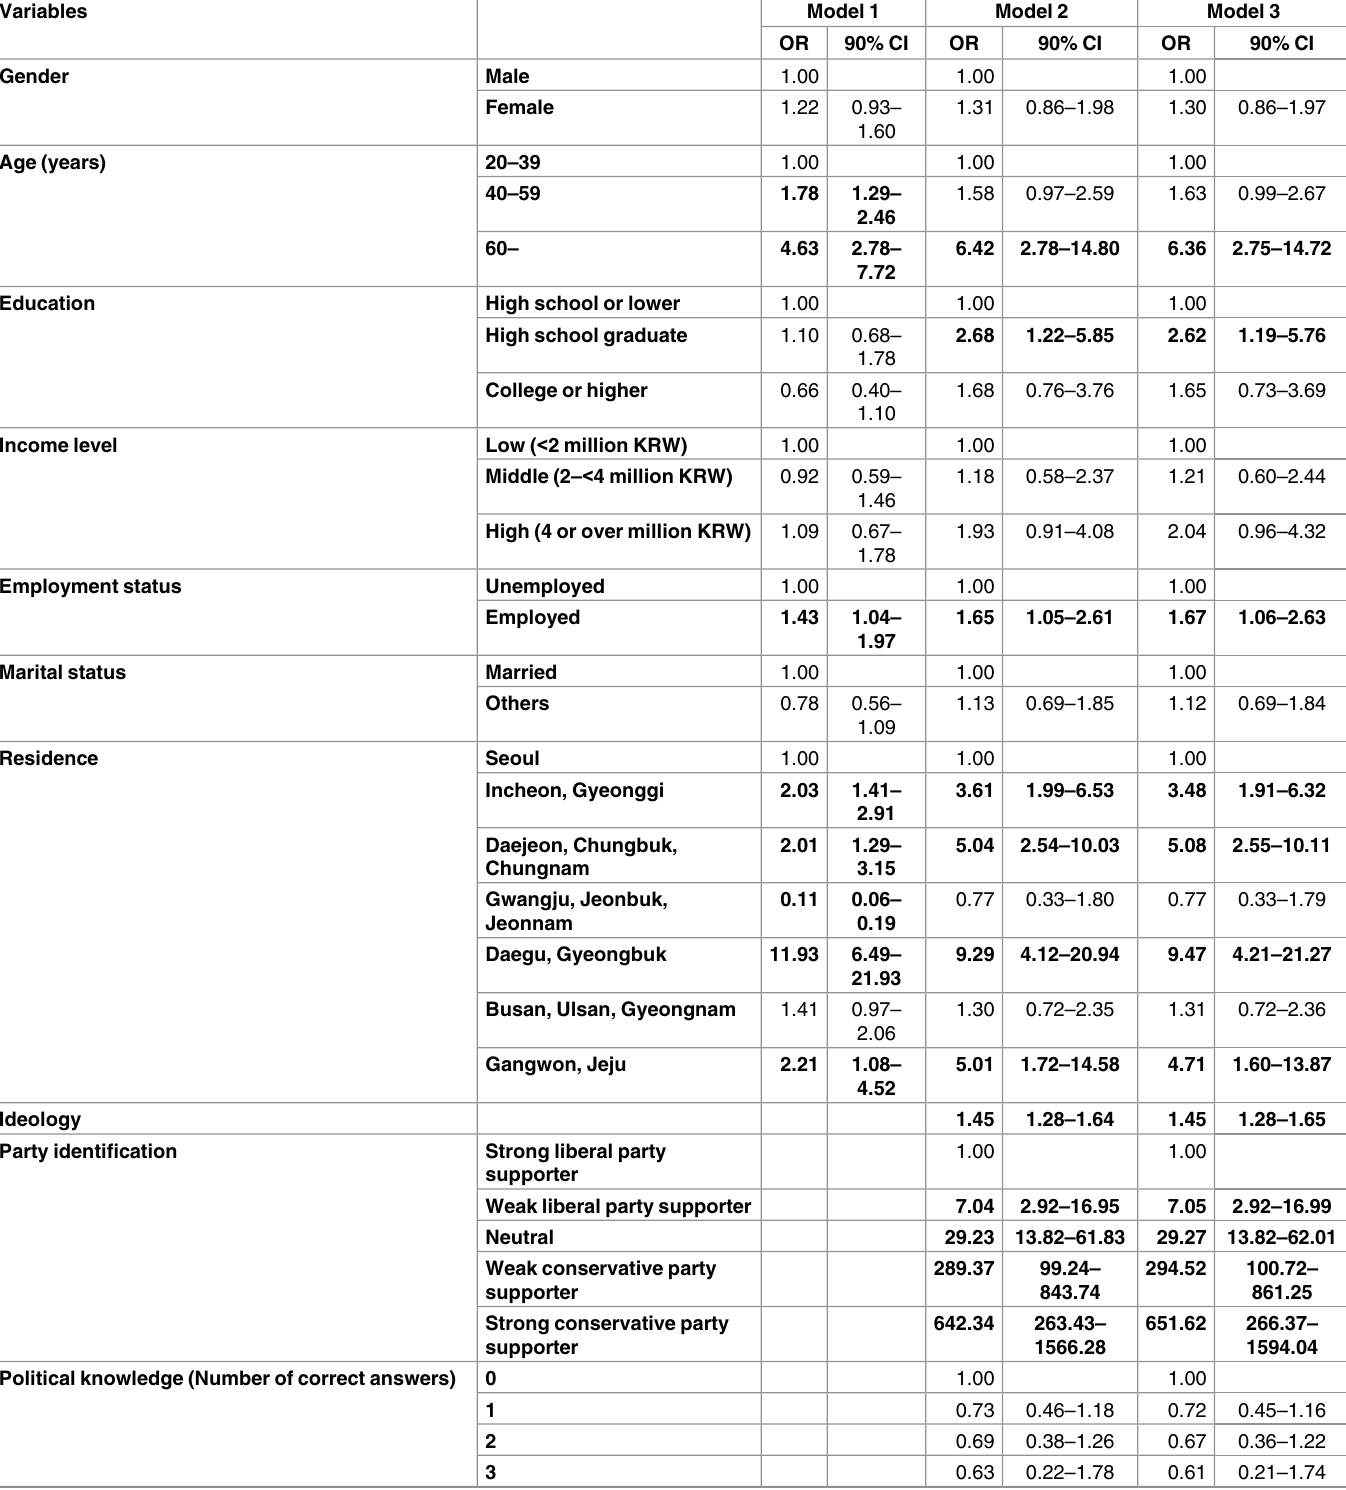
Table 3. Factors Affecting Vote for the Conservative Presidential